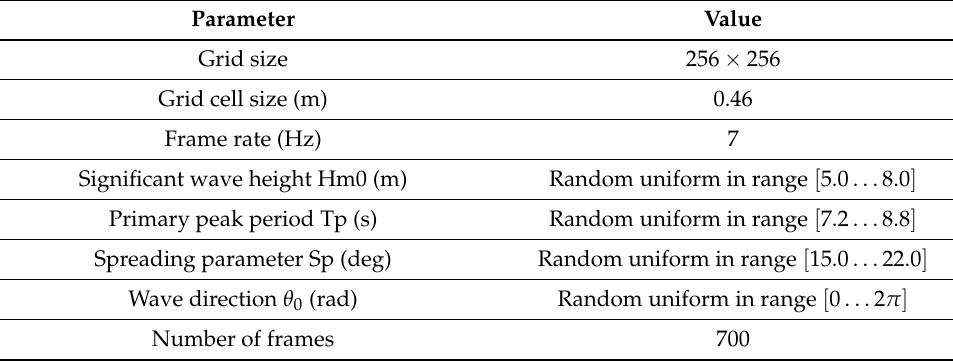
Table 1. Parameters used to generate different scenarios used for training.